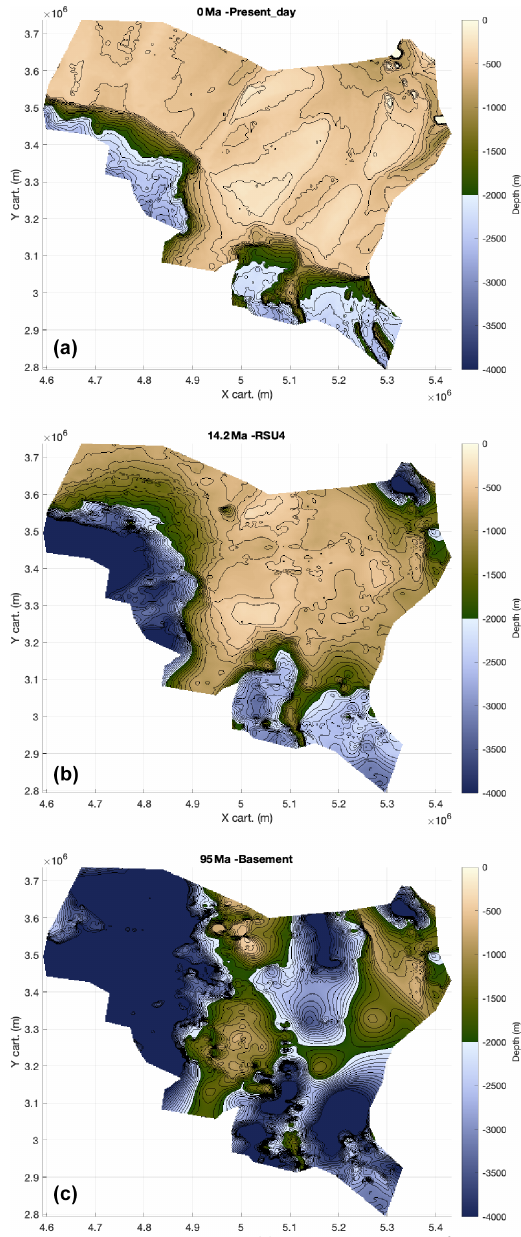
Figure 9. Initial input present-day depths ( m ) : (a) bathymetry, (b) mid-Miocene unconformity RSU4, and (c) basement both from ANTOSTRAT atlas (Brancolini et al., 1995). Layout is from the PALEOSTRIP plotting GUI; the colour scale is the default colour scale implemented within PALEOSTRIP. The colour scale has been saturated below − 4000m and above 200m for this figure: the maximum depth of the basement reaches − 10km and would have largely damped the other bathymetric changes occurring at shal- lower depths in panels (a, b) . The island located in the upper- most right corner is the only location with an elevation above sea level. Note that the colour scale is colour-blind friendly and is from Crameri et al. (2020). PALEOSTRIP has implemented 12 different colour scales, and 9 out of 12 are colour-blind